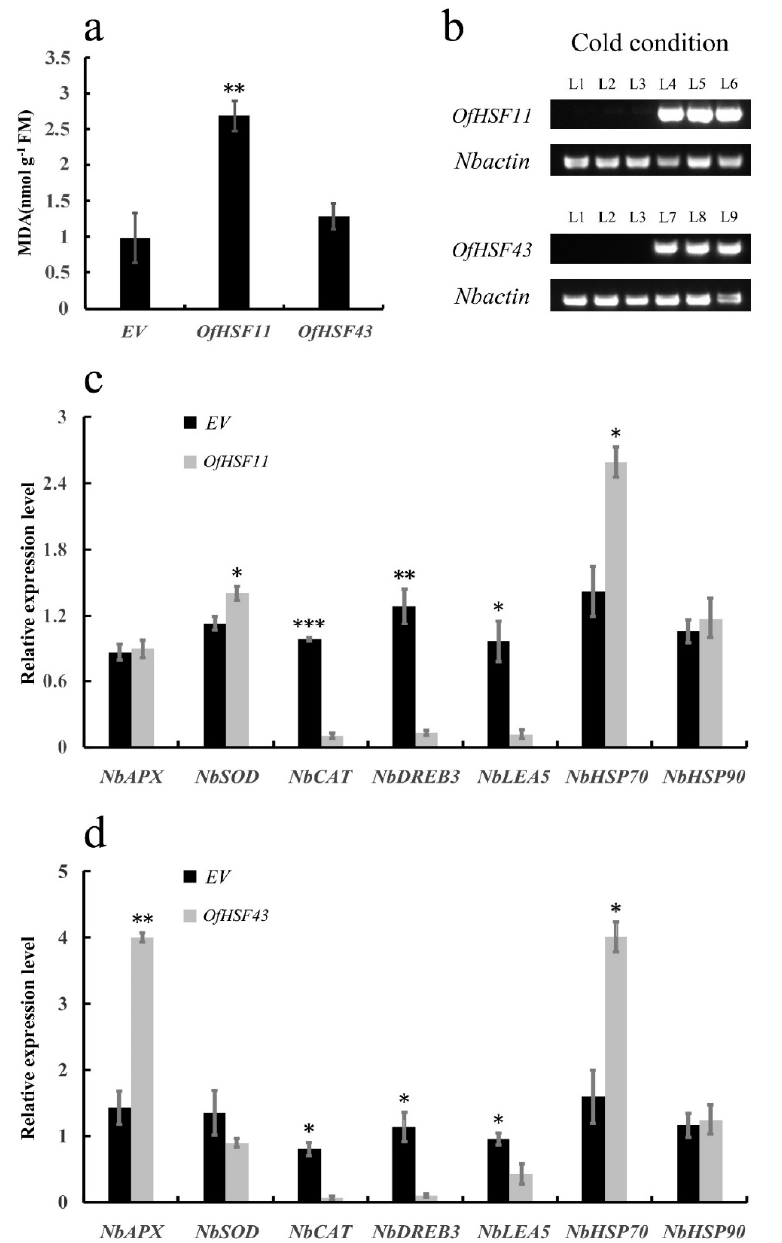
Figure 9. Physiological and biochemical changes in tobacco transiently transformed with OfHSF11 and OfHSF43 , independently. ( a ) The MDA contents of transiently transformed tobacco after a 6-h cold treatment. ( b ) The sqRT-PCR analysis of OfHSF11 and OfHSF43 expression levels in transiently transformed tobacco. Three biological replicates were infiltrated independently with the empty vector (L1-3), 35S::GFP-OfHSF11 (L4-6) and 35S::GFP-OfHSF43 (L7-9). The qRT-PCR analysis of ROS-related and stress-response genes relative expression levels in 35S::GFP-OfHSF11 transformed tobacco ( c ), 35S::GFP-OfHSF43 transformed tobacco ( d ) and the controls after cold treatment. The internal reference gene was Nbactin . Values are means ± SEs ( n = 3). The asterisks indicate significant differences as assessed by independent sample t test (* p < 0.05, ** p < 0.01, *** p <